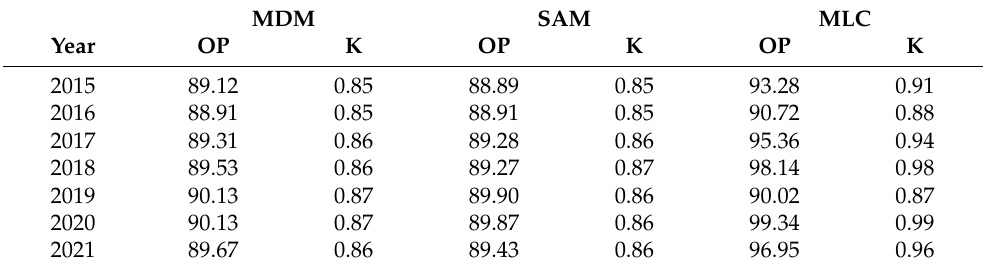
Figure 3. Maps of the macro-class-based classification for three classification methods for 2017: Top: minimum distance. Middle: spectral angle mapping. Bottom: maximum likelihood. Units: meters. Projection: WGS84 / UTM Zone 15N. Table 6. Precision assessment of the macro-class-based classification for 2017 under three classification methods. MDM SAM